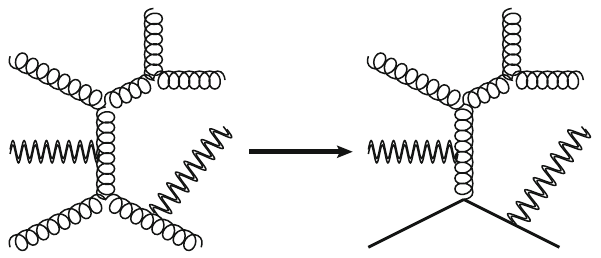
Fig. 7 Converting two massive gluons to scalars when the number of gluons is larger than